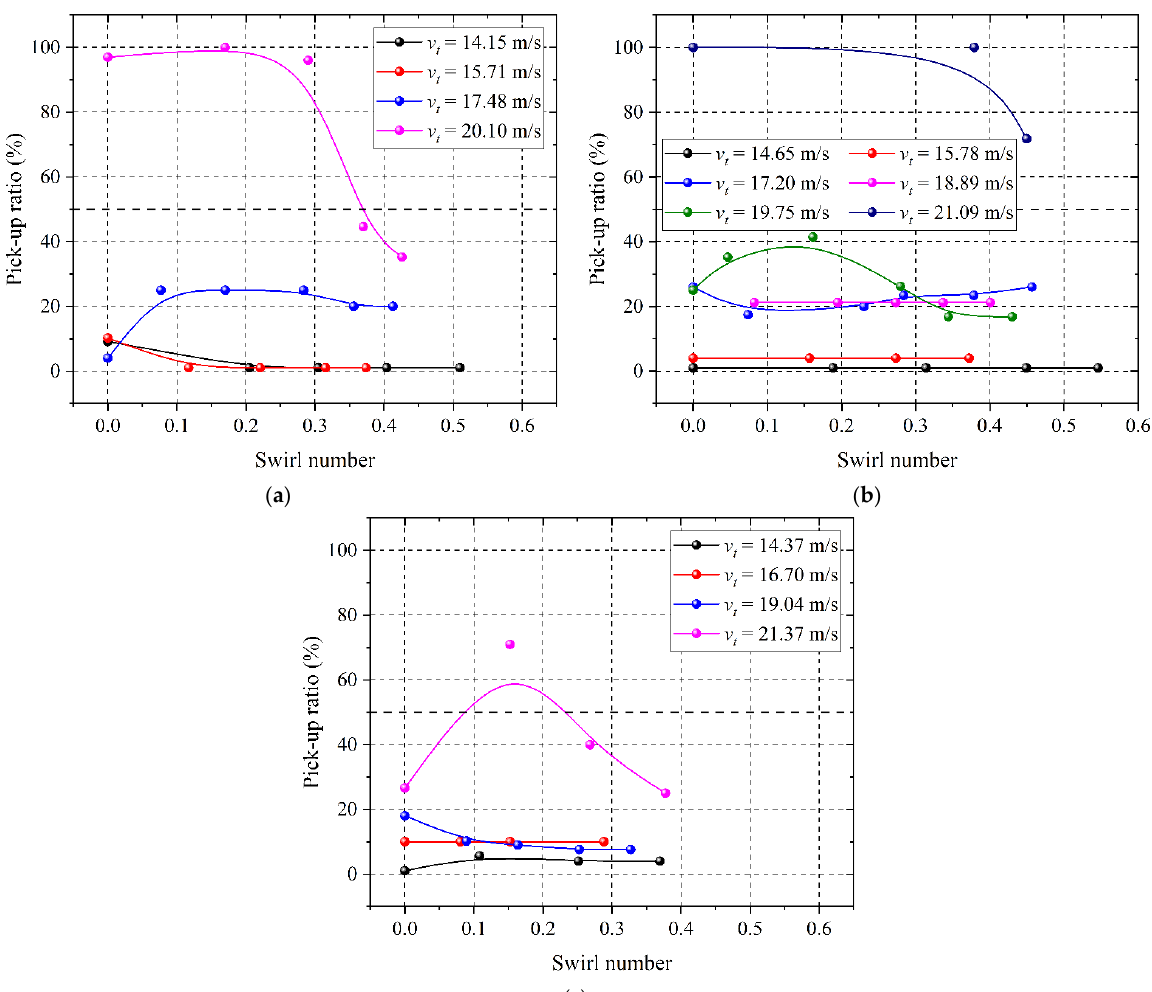
Figure 14. Effect of swirl number on picking velocity of pebble particles. ( a ) d p = 3 – 5 mm ( b ) d p = 5 – 7 mm ( c ) d p = 7 – 9 mm.